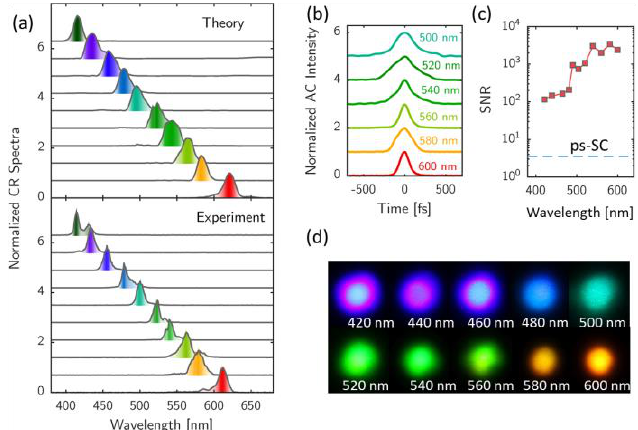
Fig. 2. Characterization of the tunable FOCR fiber laser. (a) Simulated and experimentally measured spectra of the generated tunable FOCR pulses. (b) Measured autocorrelation curves of the FOCR output. (c) The signal to noise ratio (SNR) of generated FOCR (red) and standard ps-SC source spectrally sliced with 10 nm bandwidth (FWHM) optical bandpass filters (blue). (d) The far-filed images of the generated FOCR